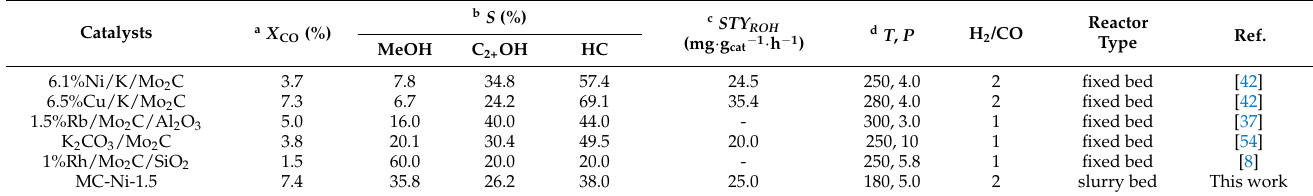
Table 3. Comparison with the activity of the catalysts in references for MAS.